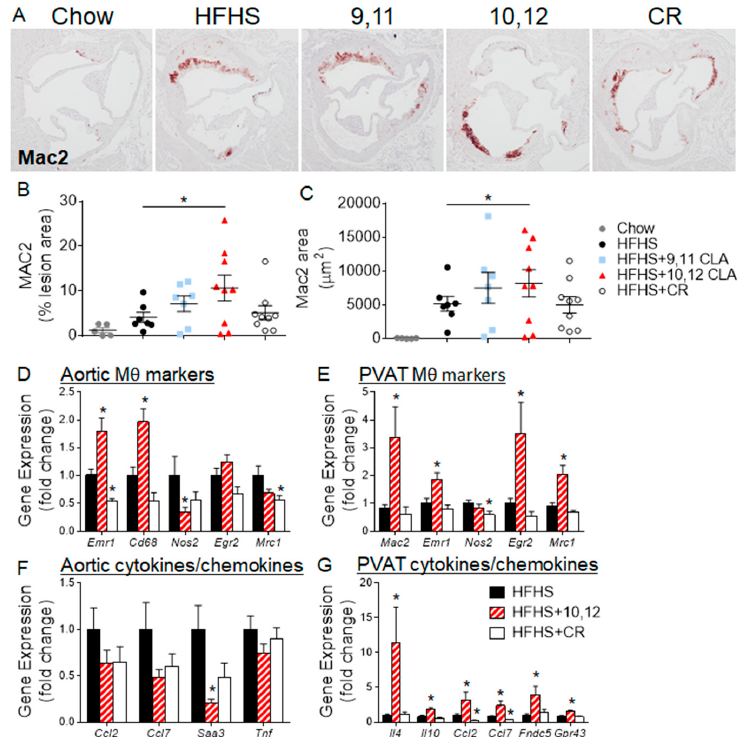
Figure 4. 10,12 CLA increases macrophage content of atherosclerotic lesions. Mice were fed either chow or HFHS diet for 12 weeks, then continued on the indicated diets for an additional 8 weeks. ( A ) Sections through the aortic sinus of the heart were stained with a Mac2 antibody, and ( B , C ) quantified using Image Pro Plus software. n = 5–10 mice/group. Different letters indicate a significant difference ( p < 0.05). ( D – G ) Gene expression was quantified from the aortic arch ( D , F ) or the surrounding perivascular adipose tissue (PVAT, E , G ) from a different cohort of different mice. n = 8 mice/group. Data are presented as mean ± SEM. * p < 0.05 from HFHS control.